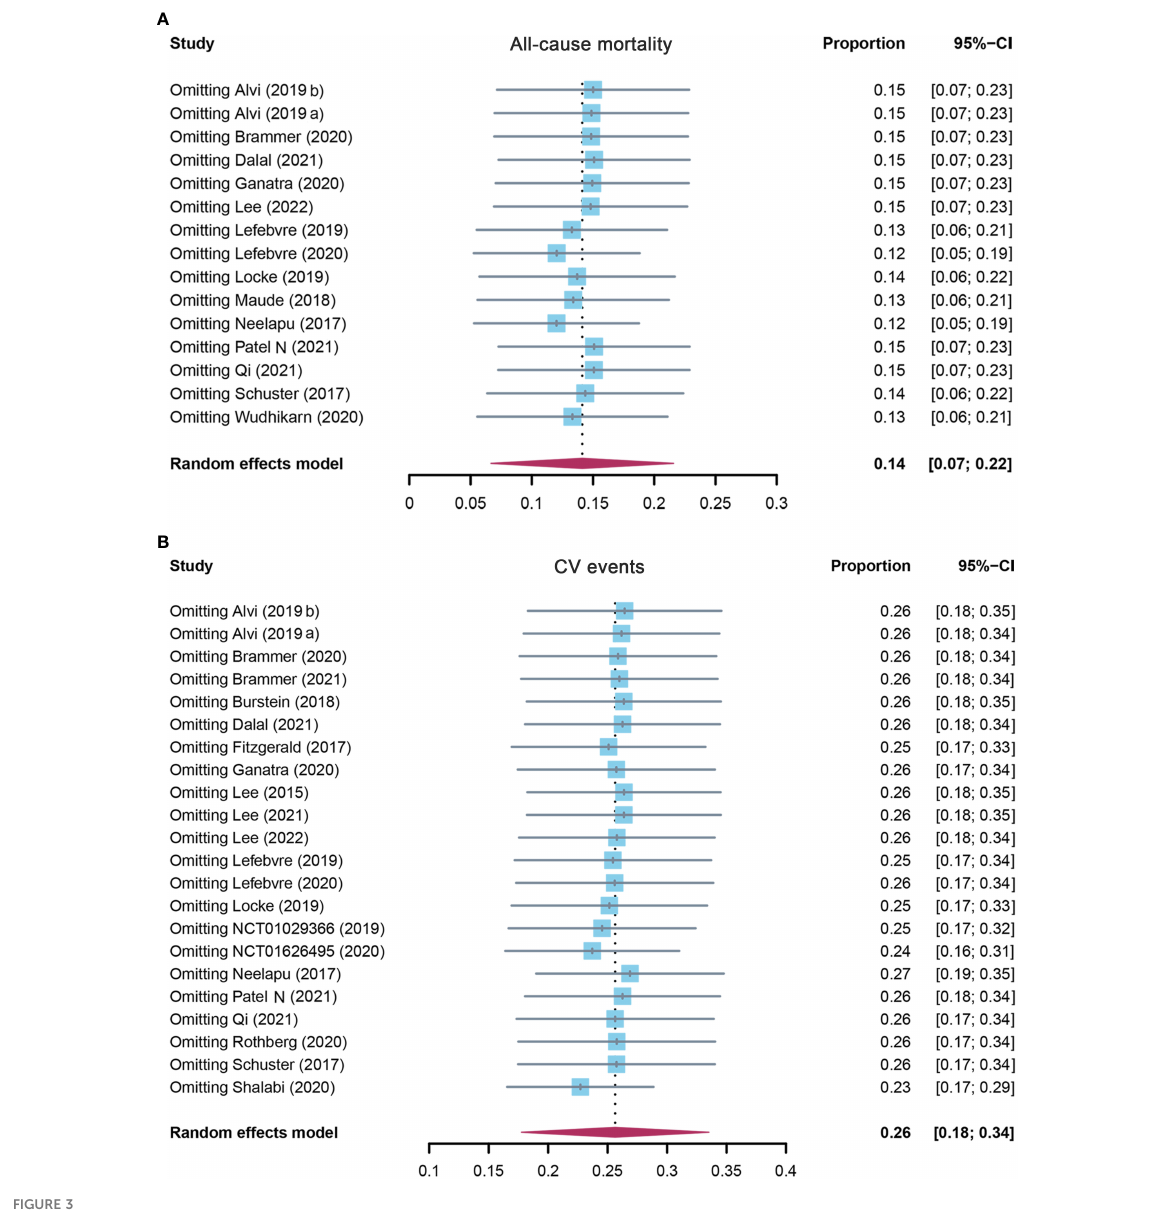
FIGURE 3 The sensitivity analysis of (A) all-cause mortality and (B) CV event incidence rate in patients who received CAR-T cell therapy. CV, cardiovascular; CAR-T cell, chimeric antigen receptor T